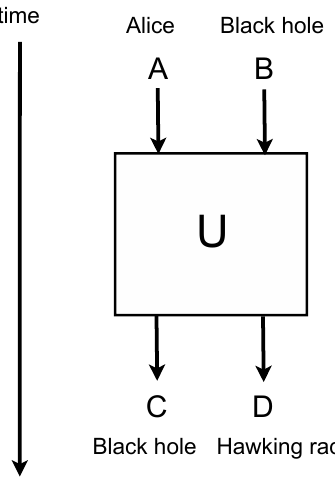
Figure 5 . A unitary operator U representing the dynamics in the Hayden-Preskill thought exper-